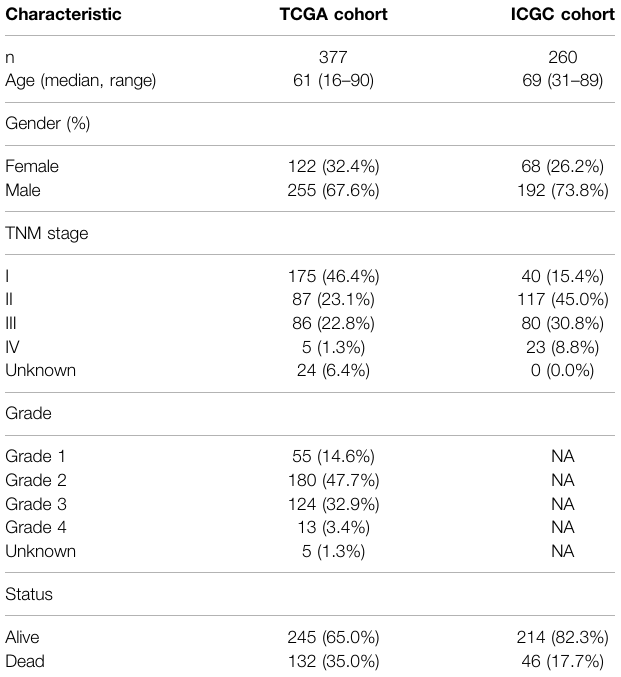
TABLE 1 | Clinical characteristics of patients in the TCGA and ICGC cohorts.